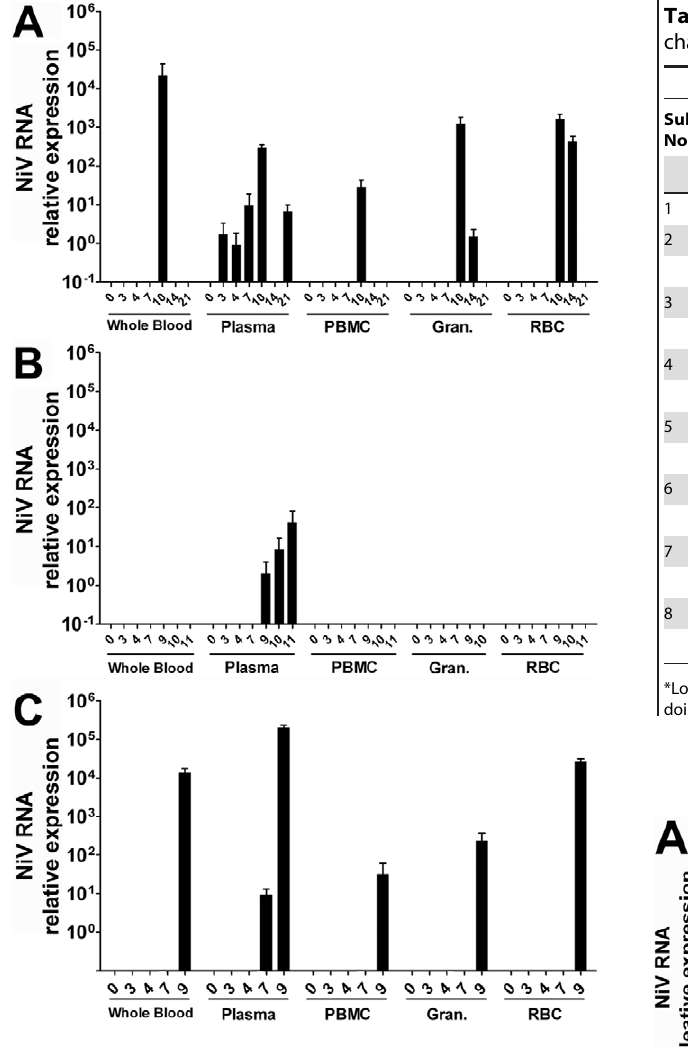
Figure 6. The normalized relative quantity of NiV RNA detected among blood samples from NiV-infected AGMs. Taqman RT-PCR was used to determine the relative NiV RNA level among samples of whole blood or blood components separated by Ficoll density centrifugation as described in the methods. (A) Low challenge dose, Subject 2; (B) Medium challenge dose, Subject 3; and (C) high challenge dose Subject 1.